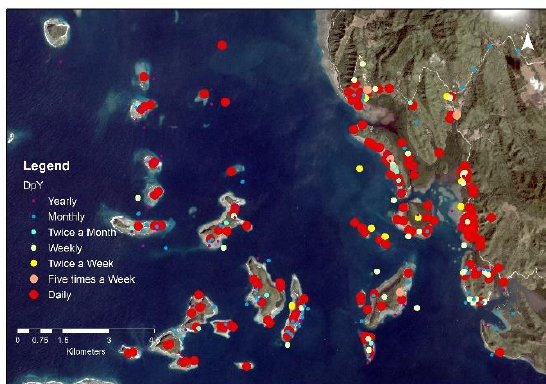
Figure 4. Frequently visited locations of all participants. The mainland (east side) is frequently visited while only a few of the participants visit the islands (west